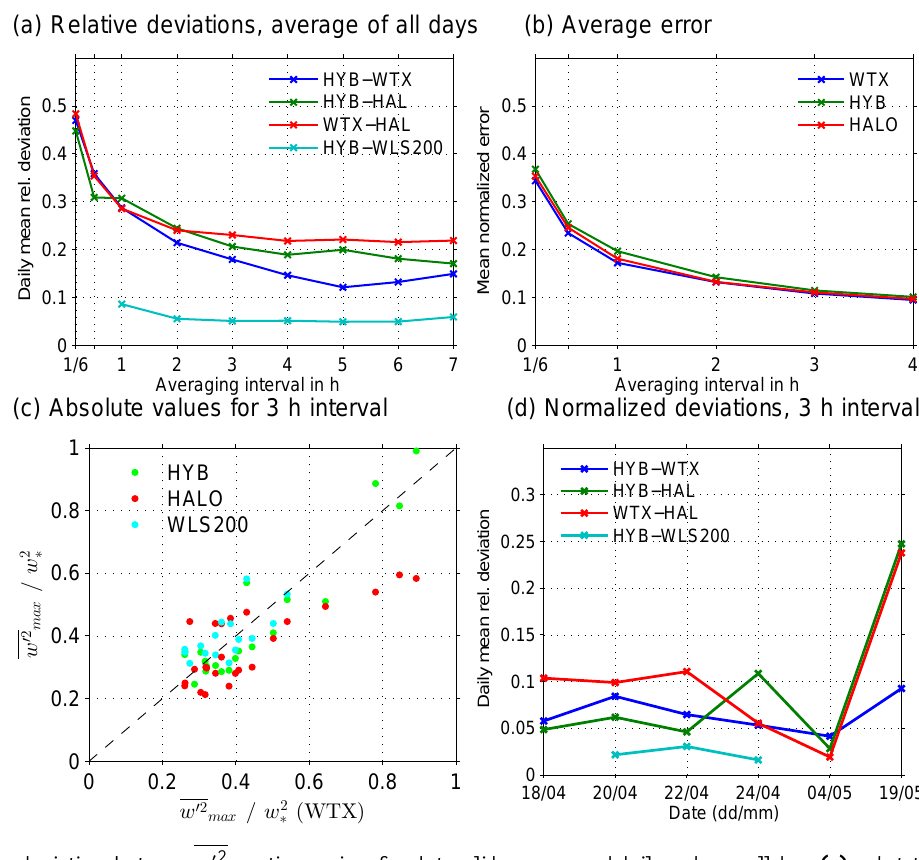
Figure 13. Relative deviations between w (cid:48) 2 max time series of each two lidars, averaged daily and over all days (a) and statistical error for each instrument, normalized with the respective w (cid:48) 2 max time series (b) , given as a function of the averaging interval used for the calculation of the variance profiles; absolute values of w (cid:48) 2 max /w 2 ∗ for the 3-h averaging interval for HYB, HALO, and WLS200 as a function of w (cid:48) 2 max /w 2 ∗ for WTX (c) ; deviation normalized with w 2 ∗ for 3-h averaging interval for each day (d)